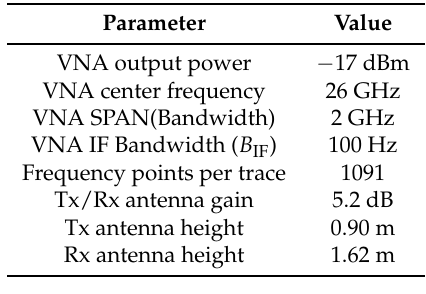
Table 1. Measurement system parameters.